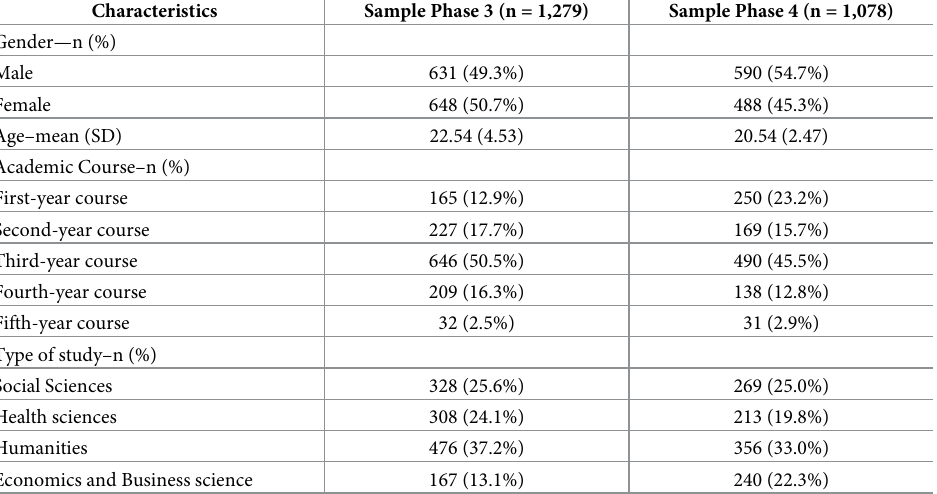
Table 1. Demographics